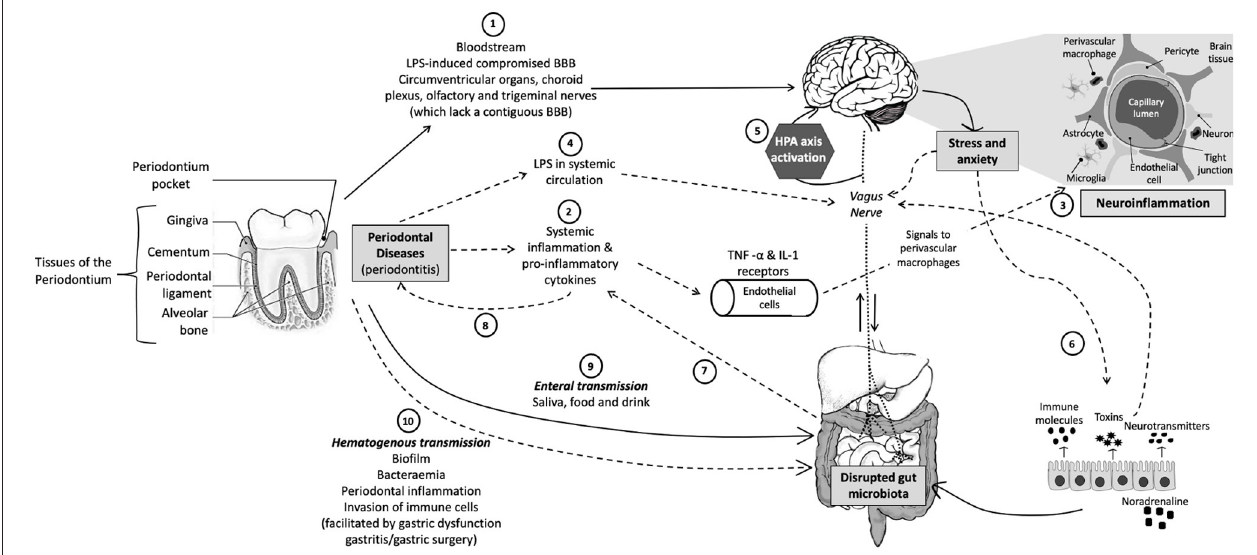
FIGURE 1 | Schematic representation of the oral-gut-brain axis. (1) Periodontal bacteria can directly reach the brain via the bloodstream or areas that lack an intact BBB or with a compromised BBB. (2) Periodontitis can indirectly affect the CNS via pro-inflammatory cytokines that activate endothelial cells that express TNF- α and IL-1 receptors, which, in turn, signal to the perivascular macrophages that communicate and activate microglia, resulting in (3) neuroinflammation. (4) Periodontitis can also result in leaky periodontium and LPS in systemic circulation, which can (5) activate the HPA axis and result in increased stress hormones or neurotransmitters, which subsequently (6) influence gut physiology, microbiota habitat, microbiota community composition, and bacterial gene expression. (7) An altered gut microbiota can result in systemic inflammation, which not only affects the CNS but also (8) exacerbates other inflammatory pathologies, such as periodontitis. Periodontal bacteria can directly influence gut microbial community composition and functioning via (9) enteral transmission or indirectly via (10) hematogenous transmission (which is facilitated by conditions such as gastritis, gastric surgery, or gastric dysfunction). CNS, central nervous system; TNF, tumor necrosis factor; IL-1, interleukin-1; LPS, lipopolysaccharide; BBB, blood–brain barrier; HPA, hypothalamic–pituitary–adrenal. Solid arrows indicate direct pathways and dotted arrows indicate indirect